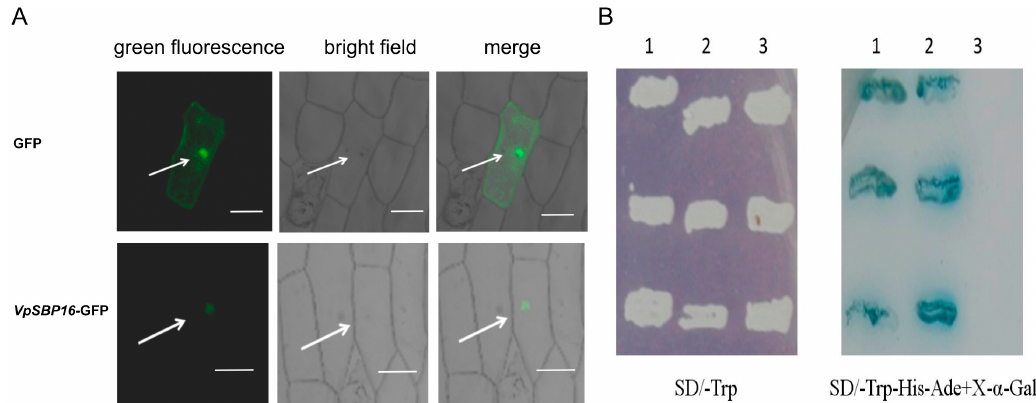
Figure 3. Subcellular localization and transcriptional activation function of VpSBP16. ( A ) Subcellular localization of the VpSBP16-GFP (bottom row) fusion protein (top row) in onion epidermal cells. White arrowheads indicate the location of the nucleus in onion epidermal cell, scale bars: 50 μ m. ( B ) Transcriptional activation function of VpSBP16 in yeast. Yeast cells containing the different plasmids grown on SD/-Trp select medium ( left ). Yeast cells containing the different plasmids grown on SD/-Trp-His-Ade+X- α -gal selection medium ( right ). 1: Positive control. (pGBKT7-Gal4); 2: pGBKT7-VpSBP16; 3: Negative control (pGBKT7). The experiments were repeated three times with